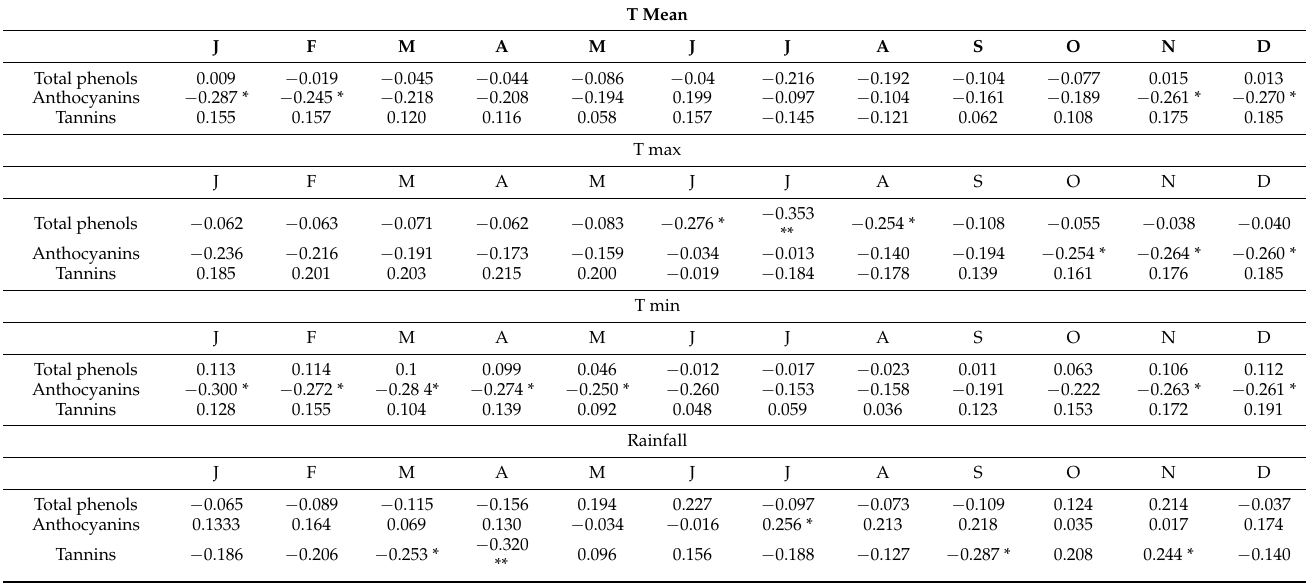
Table 2. Correlation of average, maximum and minimum temperature and rainfall parameters with total phenols, anthocyanins and tannins in myrtle berry using a Pearson’s correlation at two levels of significance (** p < 0.05, * p <